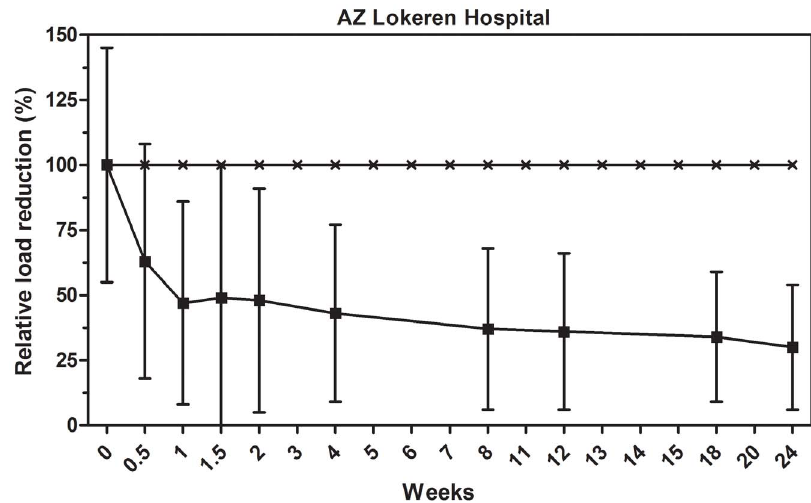
Figure 3. Effect of microbial cleaning on C.difficile surface counts. Surface counts are reported as relative percentage of reduction compared to the control, which was cleaned with conventional (disinfecting) cleaning products. The statistical analysis is reported in Table S4.